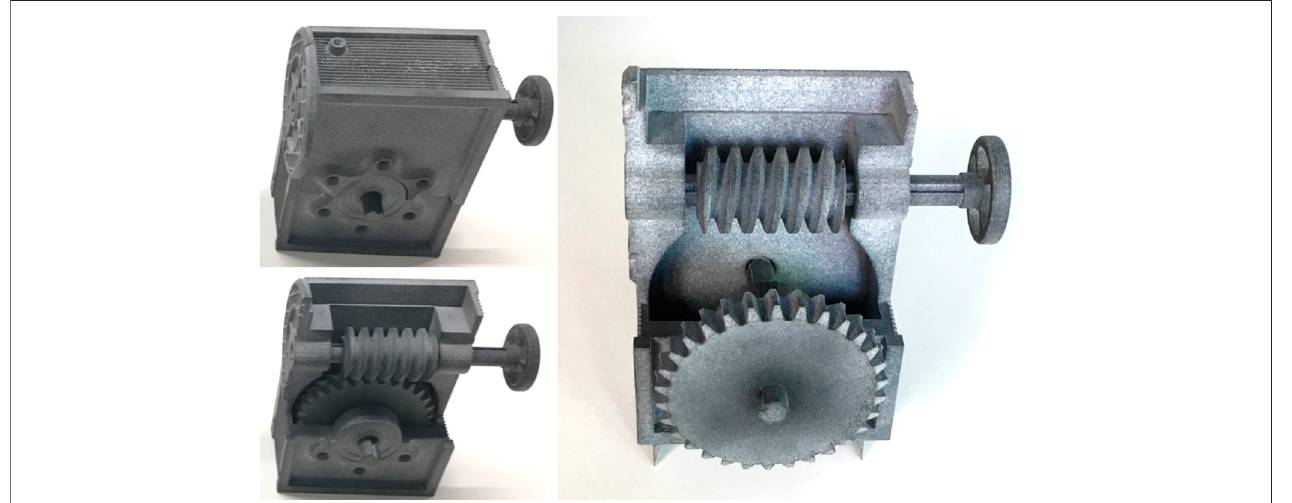
FIGURE 11 | The gearbox assembled by an untrained subject (right) and the correct example (left)